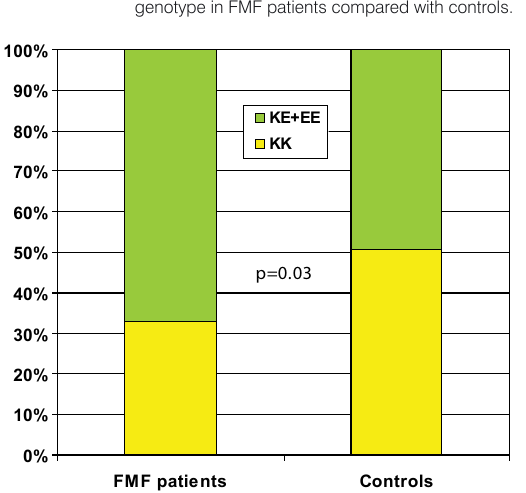
Figure 1. Significantly less frequent ICAM-1 K469 homozygote genotype in FMF patients compared with controls.